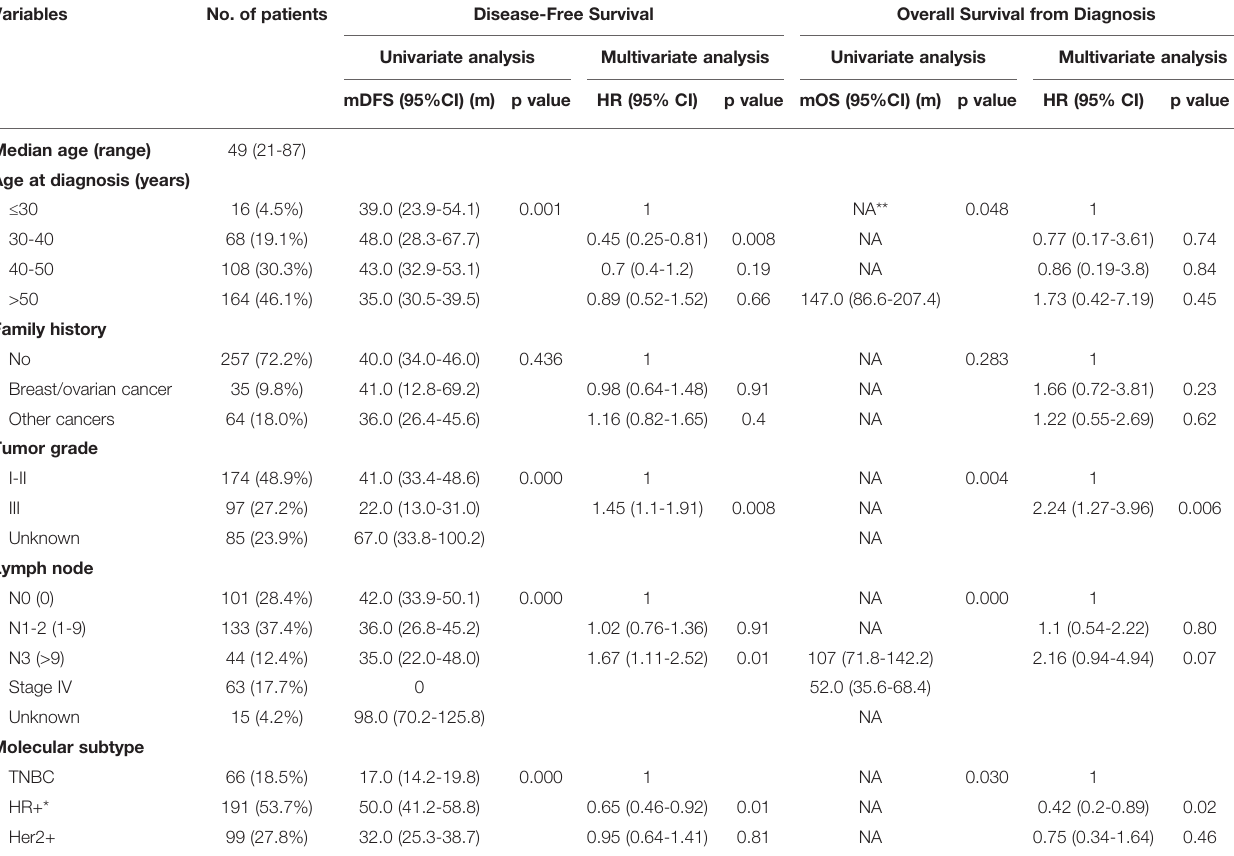
TABLE 1 | Analysis of clinical parameters and survival